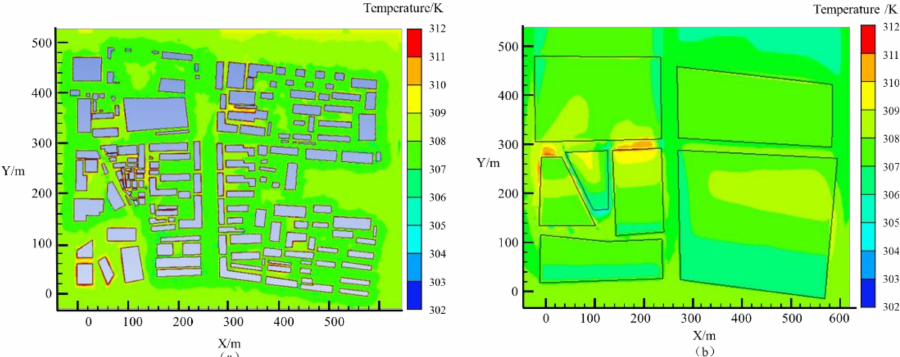
Figure 11. Diagram of temperature distribution modeled by the ( a ) standard CFD method and ( b ) porous media